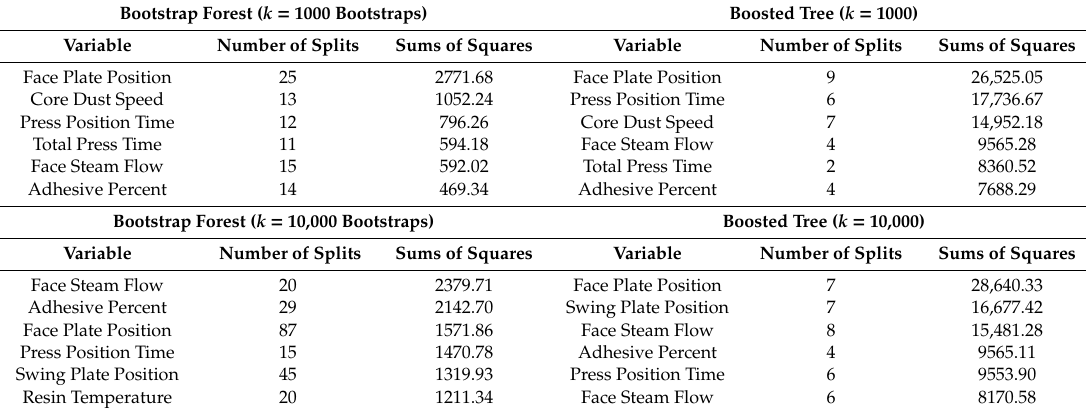
Table 2. Common predictors variables for 10-fold cross validation for both bootstrap forest and boosted tree models for MDF after k = 1000 bootstraps and k = 10,000, ranked by highest sums of squares.